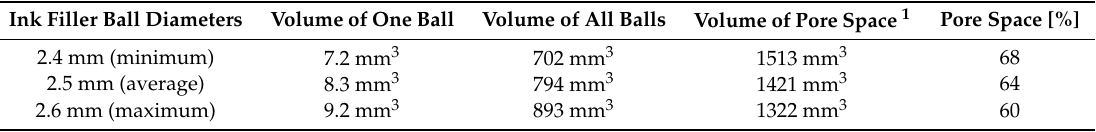
Table 3. Range of pore space in container with 97 ink filler balls considering the tolerance of the diameter (2.5 ± 0.1 mm).